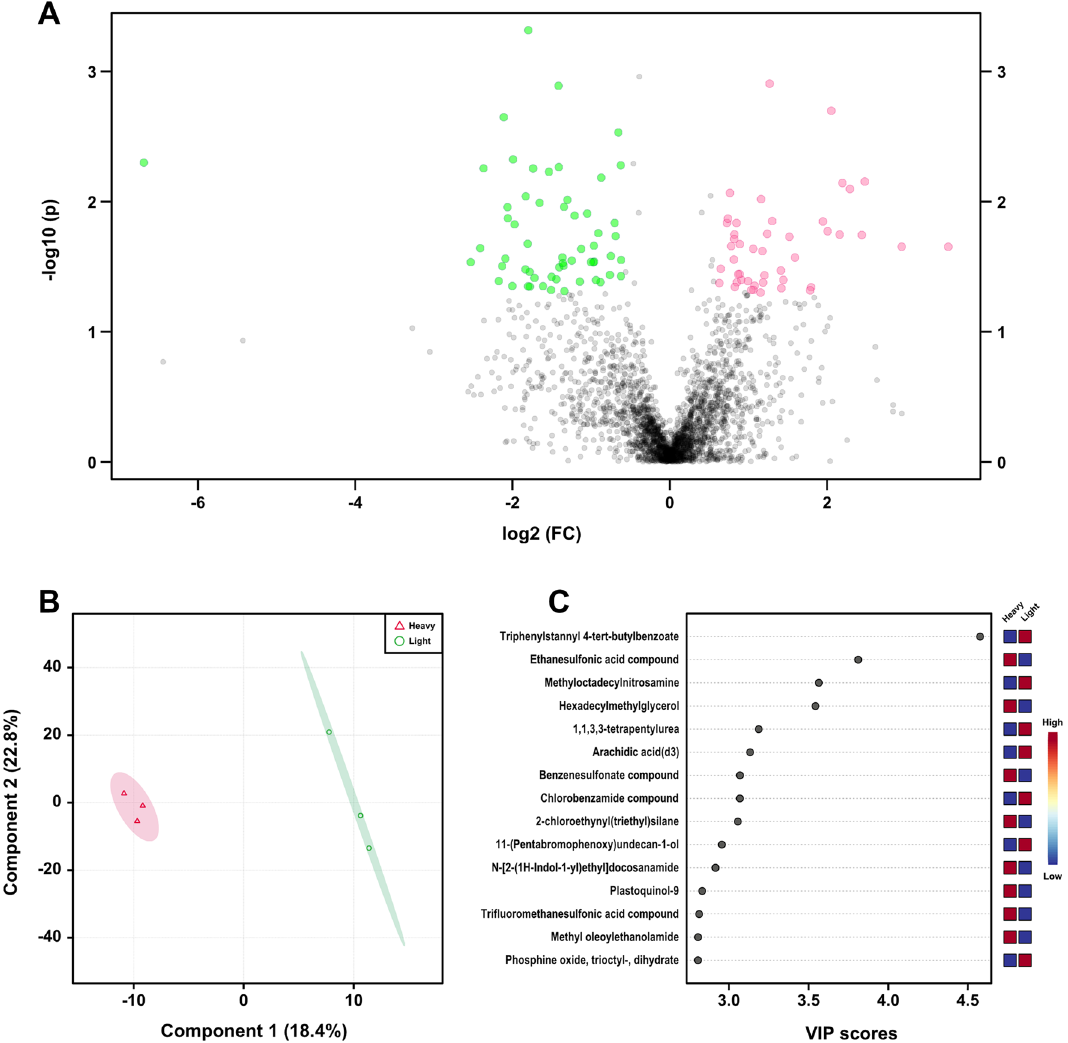
Figure 3. Gut metabolomics for quantification of metabolites based on positive ion mode between the heavy and light infected ascariasis. ( A ) Volcano plot showing the statistical significance and fold change of metabolites in heavy infected (red) compared to light infected (green) of ascariasis ( P < 0.05, Fold change ≥ 1.5). ( B ) Score plots of partial least squares discriminant (PLS-DA) analysis of metabolome from heavy and light infected samples. The color around each group represents the 95% confidence intervals. ( C ) The plot representing 15 m/z features with top variable importance in projection (VIP) score calculated based on PLS-DA